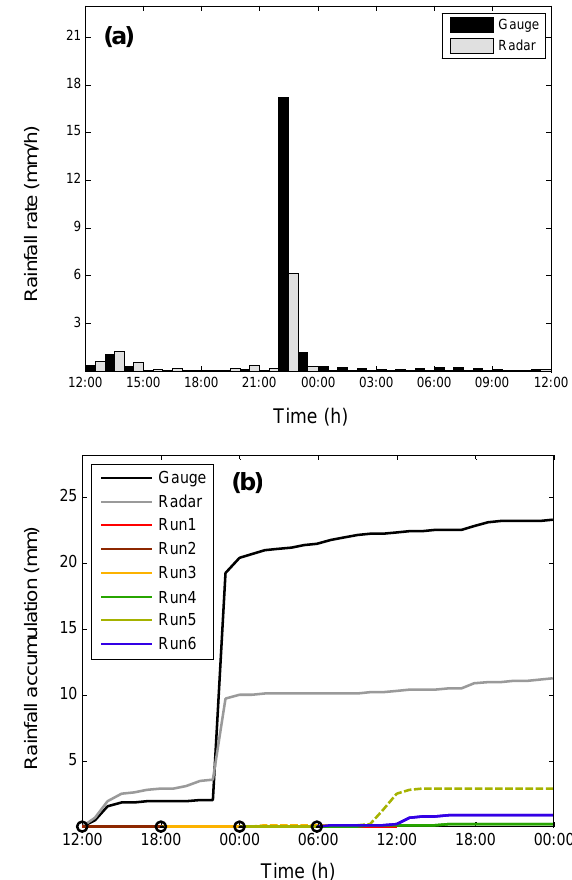
Figure 7 Data assimilation results for a highly convective storm: (a) radar and rain gauge Fig. 7. Data-assimilation results for a highly convective storm: (a) radar and rain gauge observations for the 24h duration (3 Au- observations for the 24h duration (03/08/1994 12:00 ~ 04/08/1994 12:00); (b) rainfall gust 1994 at 12:00–4 August 1994 at 12:00); (b) rainfall cumulative curves after assimilating both radar reflectivity and NCAR surface cumulative curves after assimilating both radar reflectivity and NCAR surface and upper-air and upper-air observations (24h duration + observations (24h duration + 12h)